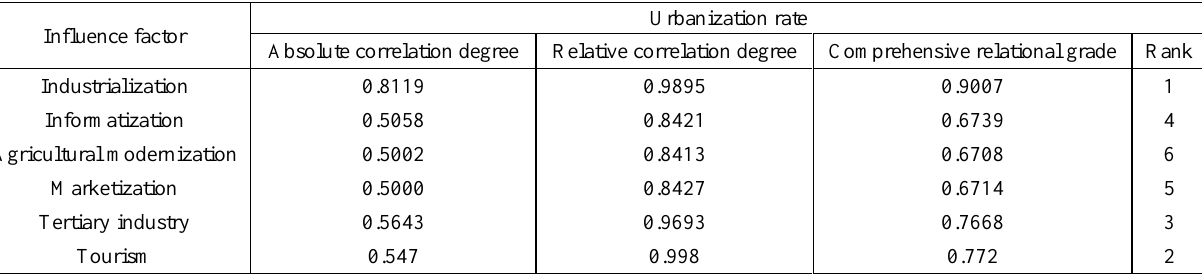
Table 4. Grey correlation degree